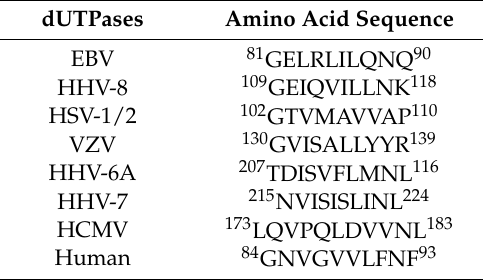
Table 2. TLR2 putative binding motif.